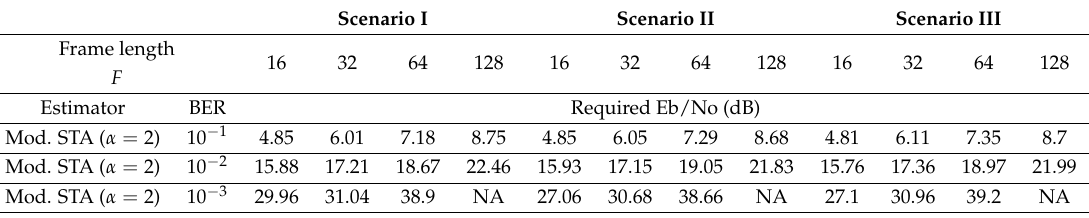
Table 8. Required Eb/No levels to attain 10%, 1%, and 0.1% BER over Scenarios I, II, and III by employing the STA modification proposal for different frame lengths with initial speeds